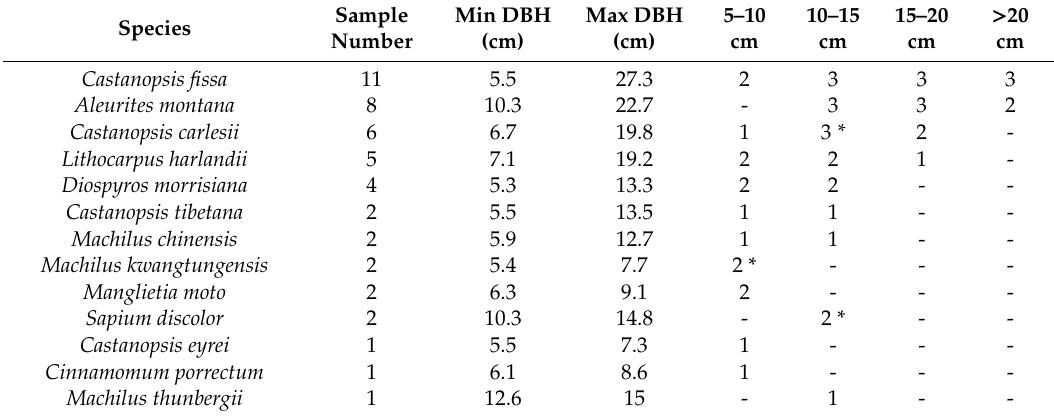
Table 1. The species composition, sampled number and diameter class distribution of sampled